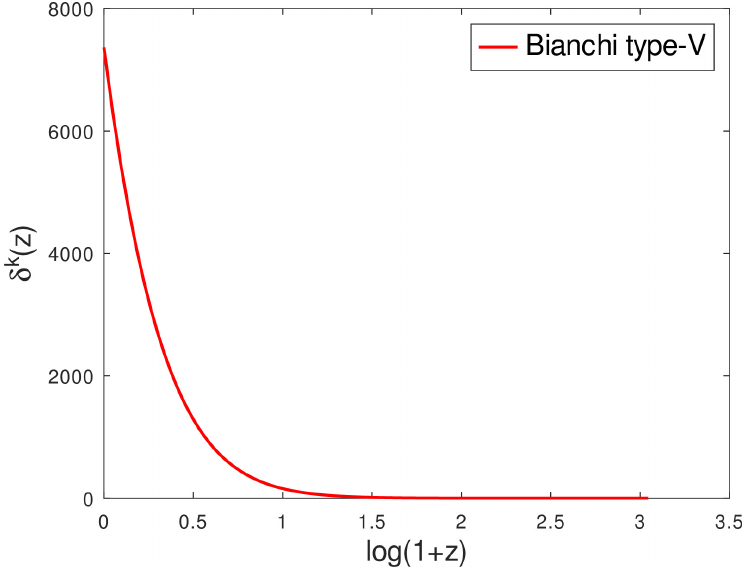
Figure 5. The variation of the matter density perturbations δ k ( z ) for a Bianchi type-V model for non- viscous ( α = 0 = β ) fluid, but with changing G and Λ vs. redshift. The current values from [49] h ( 0 ) = 1, Ω m ( 0 ) ≡ Ω m 0 = 0.3111, Ω Λ ( 0 ) ≡ Ω Λ 0 = 0.6889, Ω χ 0 = − 0.0007, Ω σ 0 = 1 − Ω m 0 − Ω Λ 0 − Ω χ 0 have been used for the background, whereas ∆ k ( z in ) = 10 − 5 , Z k ( z in ) = 10 − 5 and Σ k ( z in ) = 10 − 5 have been used as initial conditions for the perturbations, along with the fourth-order Runge–Kutta method to integrate the system